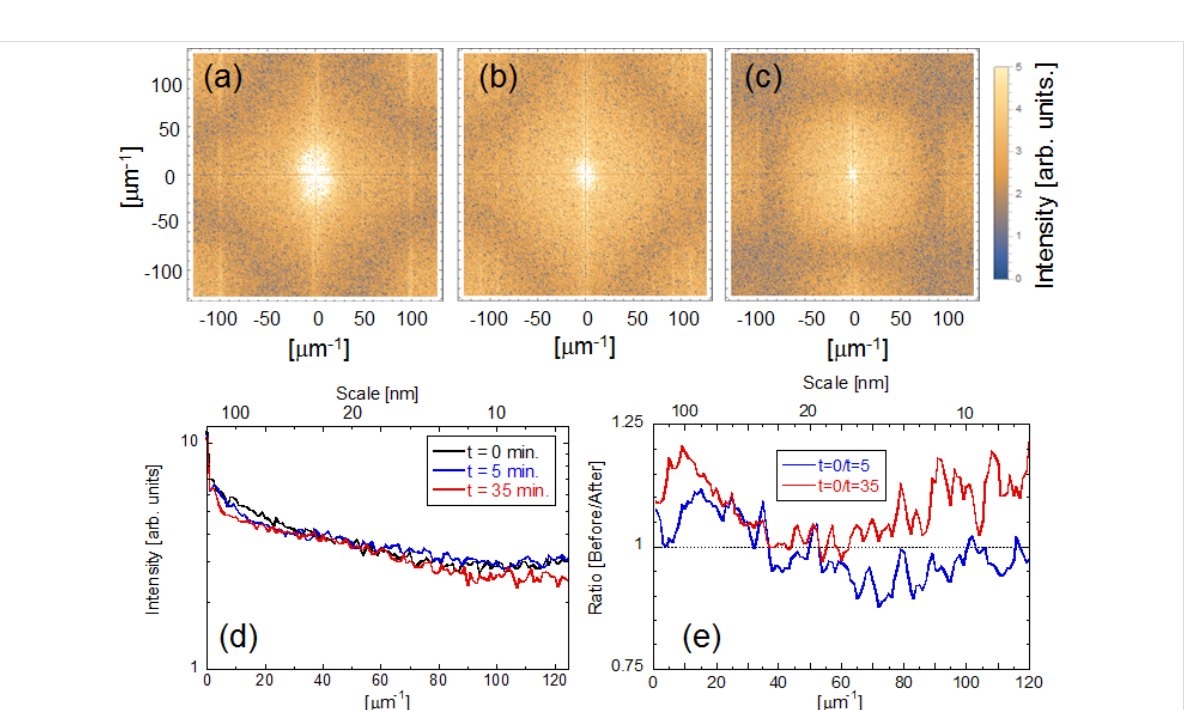
Figure 4: Time dependence of Fourier power spectra using a solution. Fourier power spectra taken (a) before etching, (b) after 5 min, and (c) after 35 min. (d) Averaged cross-sectional profiles. (e) Ratio of the power spectra before etching to the power spectra after etching. Blue solid line: before ( t = 0 min)/after ( t = 5 min), red solid line: before ( t = 0 min)/after ( t = 35